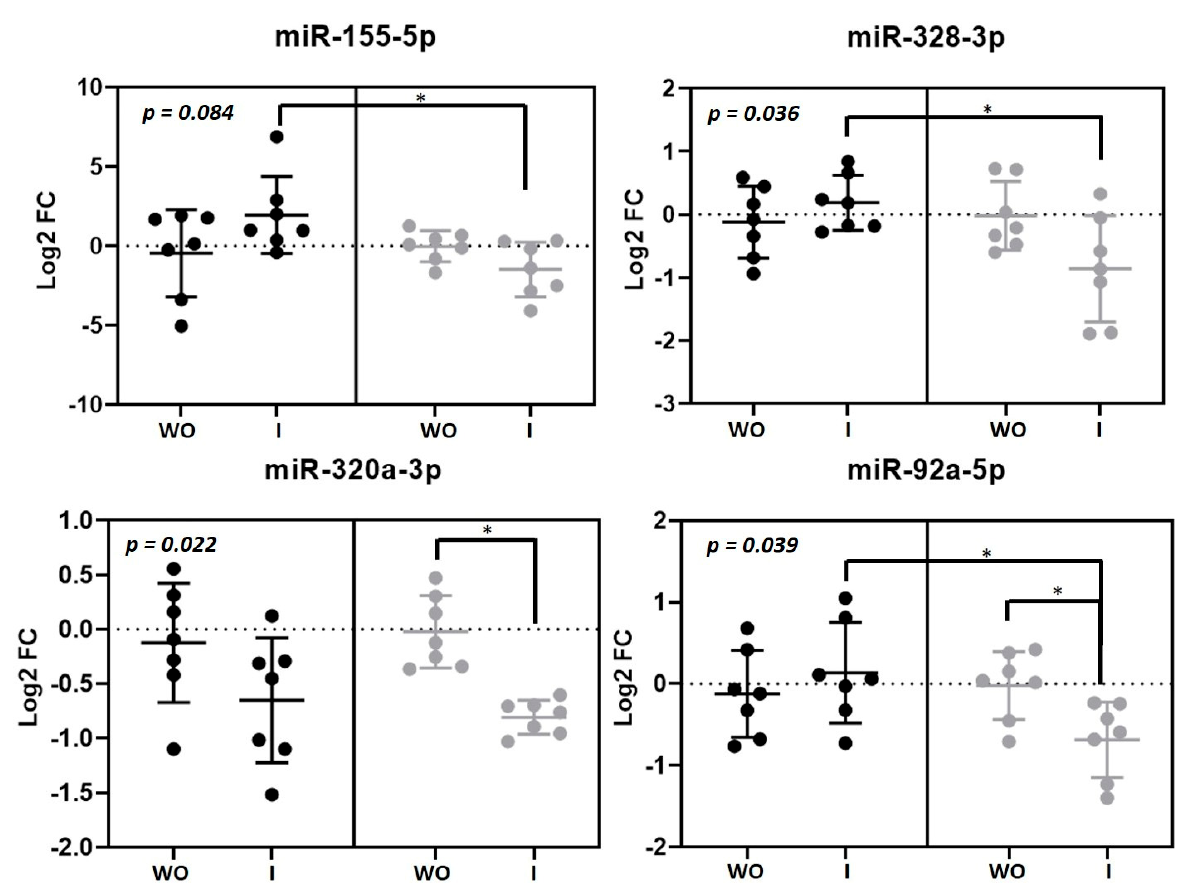
Figure 2. Circulating microRNAs modulated by beer and non-alcoholic beer. Scatterplots showing Log 2 transformed relative fold change (FC) microRNAs in each intervention phase ( n = 7). Black dots ( • ) correspond to beer intervention and grey dots ( • ) correspond to non-alcoholic beer intervention. Plasma microRNA levels were calculated with the 2 − ∆∆ Ct method comparing with each basal timepoint. Mean ± SD of each timepoint is shown. p -value was calculated with repeated measurements ANOVA. * p < 0.05 for the paired t -test comparison between timepoints. WO: washout; I: intervention. Five microRNAs were modulated by beer intake in macrophages miR-145-5p ( p =